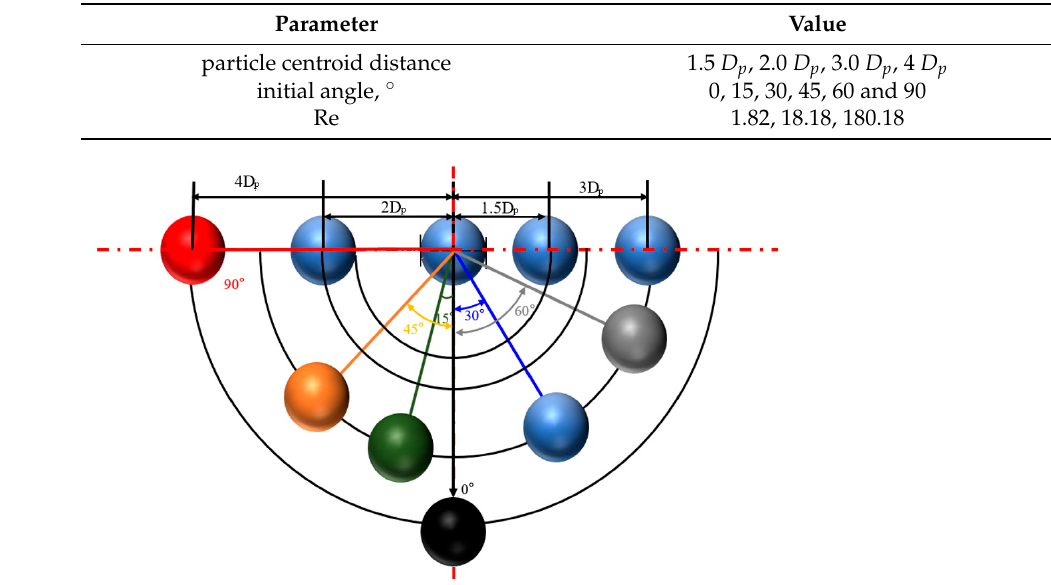
Table 2. Summary of simulation parameters exploring the effect of relative position and particle Re on DKT.